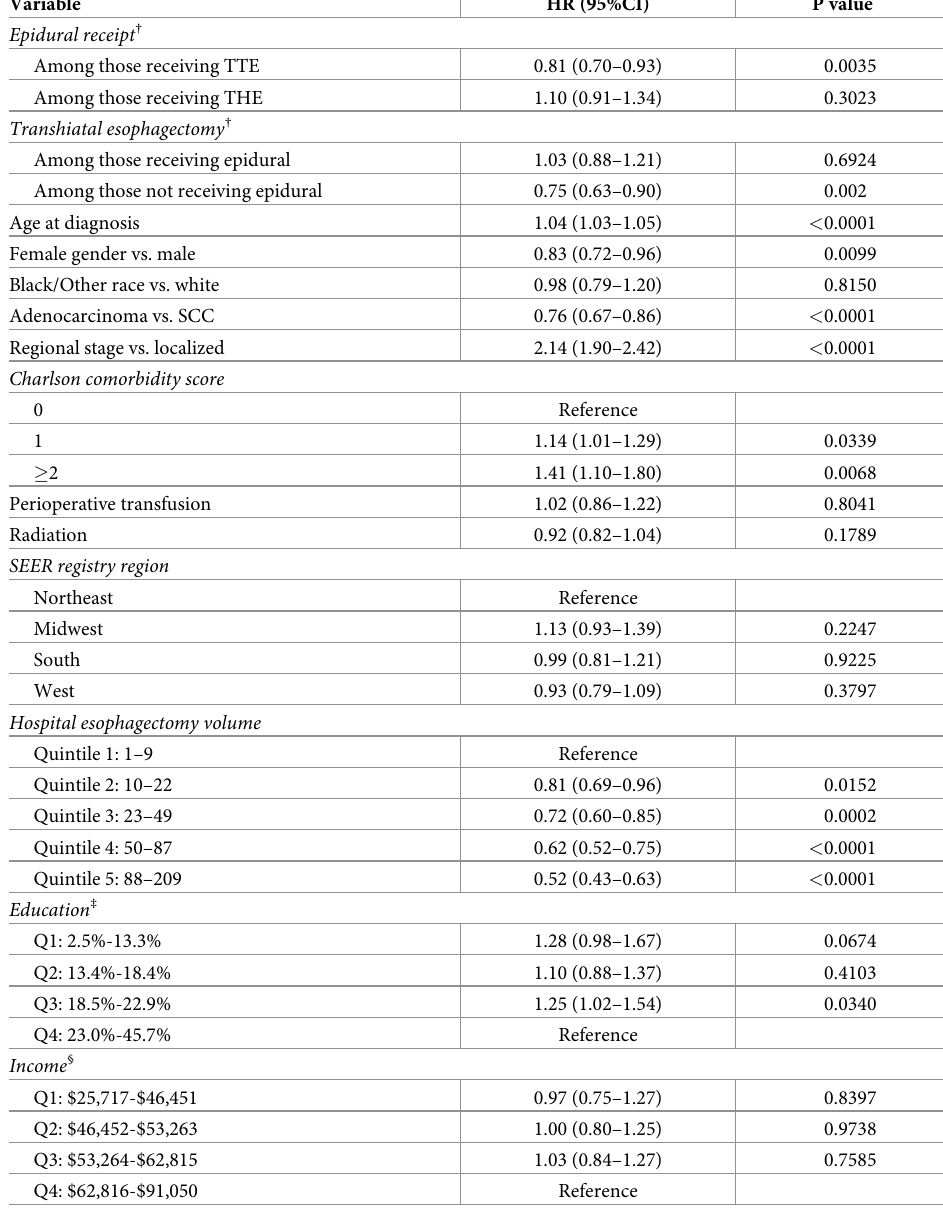
Table 2. Marginal Cox model for time to death (5-year